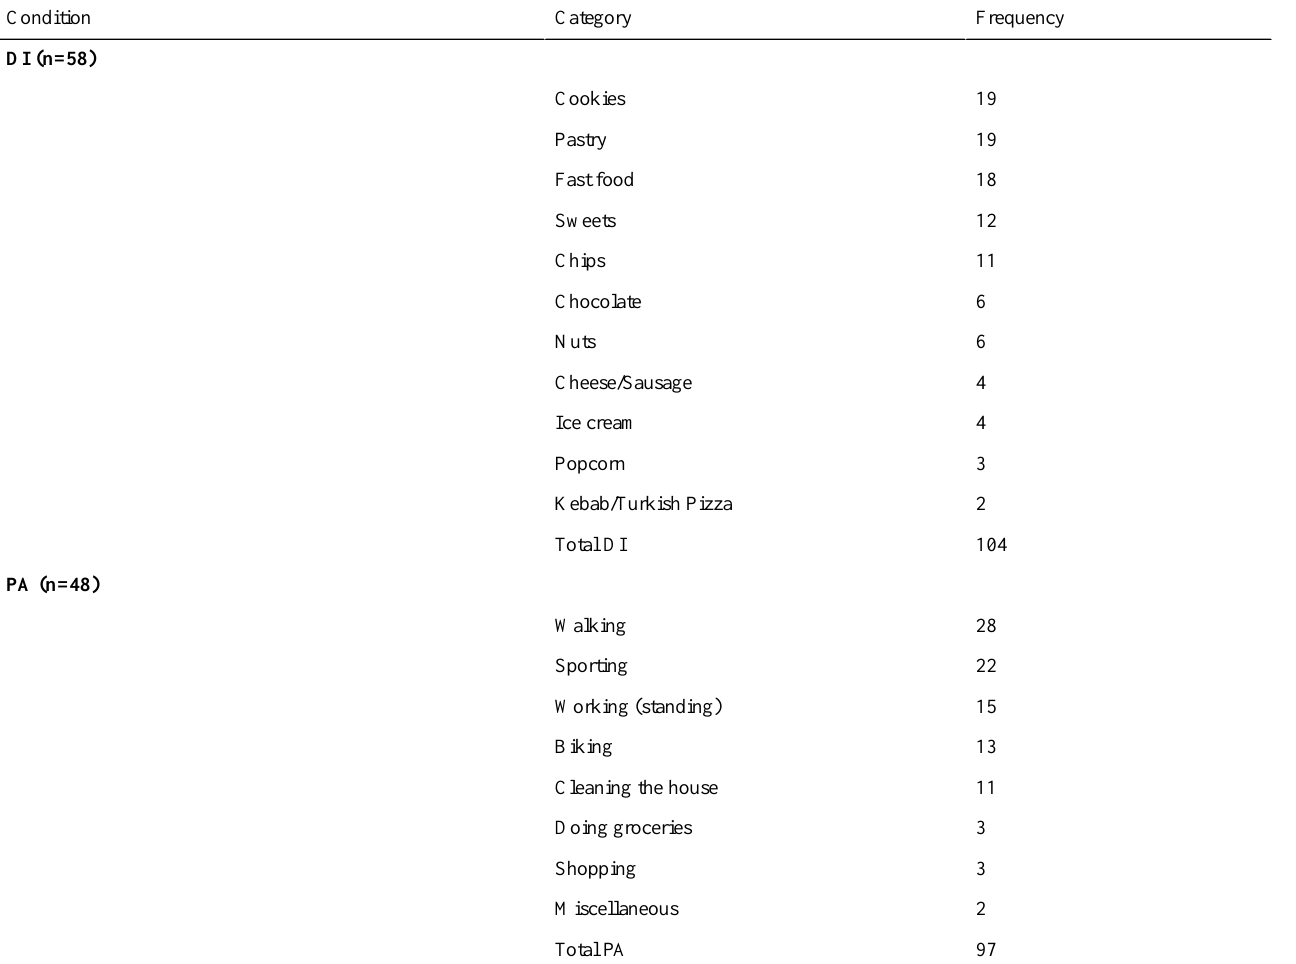
Table 2. Vocational education school students’Dietary Intake (DI) and Physical Activity